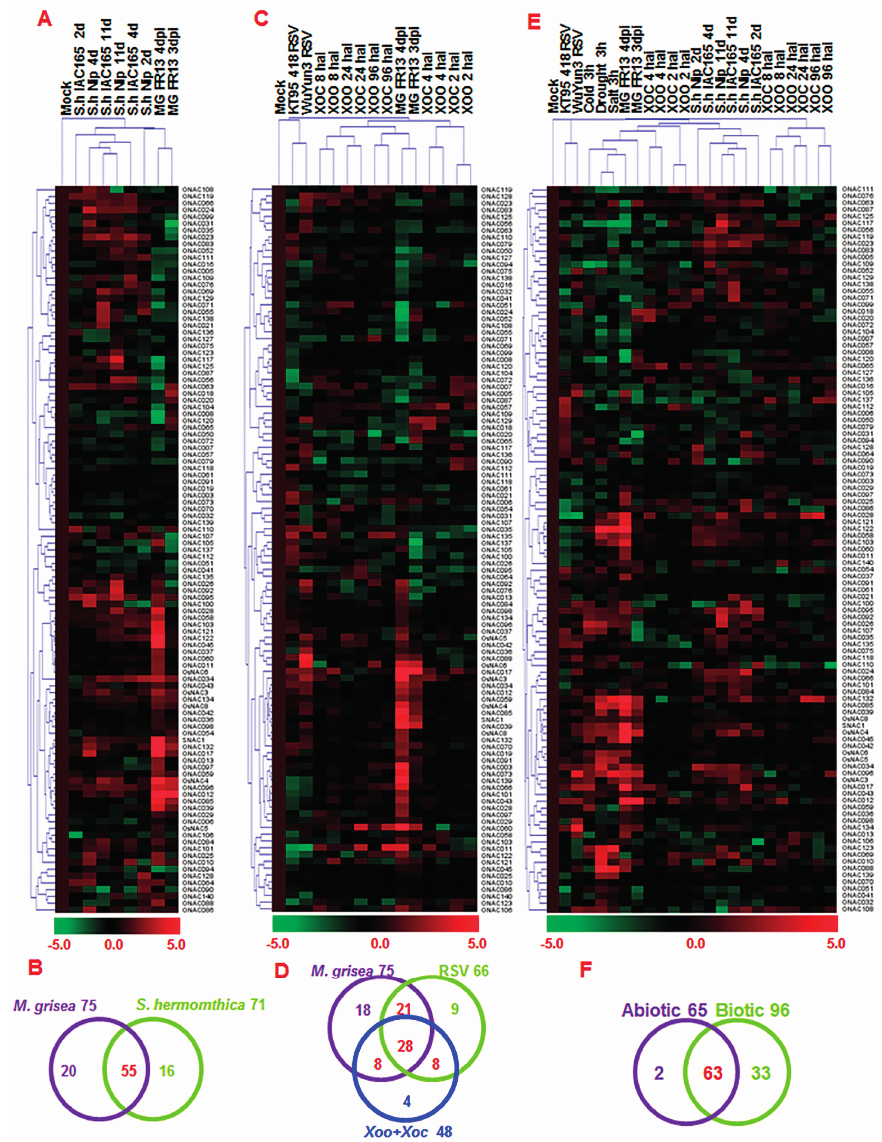
Figure 5. Overlapping expression of ONAC genes in response to various biotic and abiotic stresses. ( A ) Heat map of ONAC genes, showing differential expression patterns